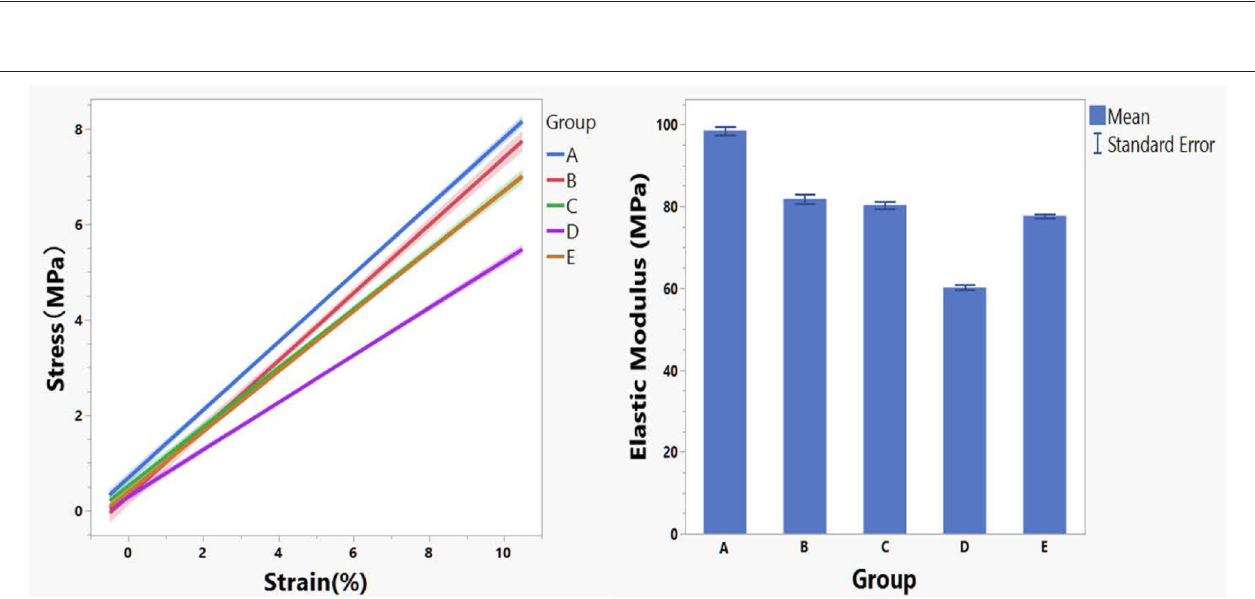
FIGURE 2 | Regression lines of stress–strain data within 10% strain stratified by crosslinking conditions (left panel) and the corresponding mean modulus (right panel).